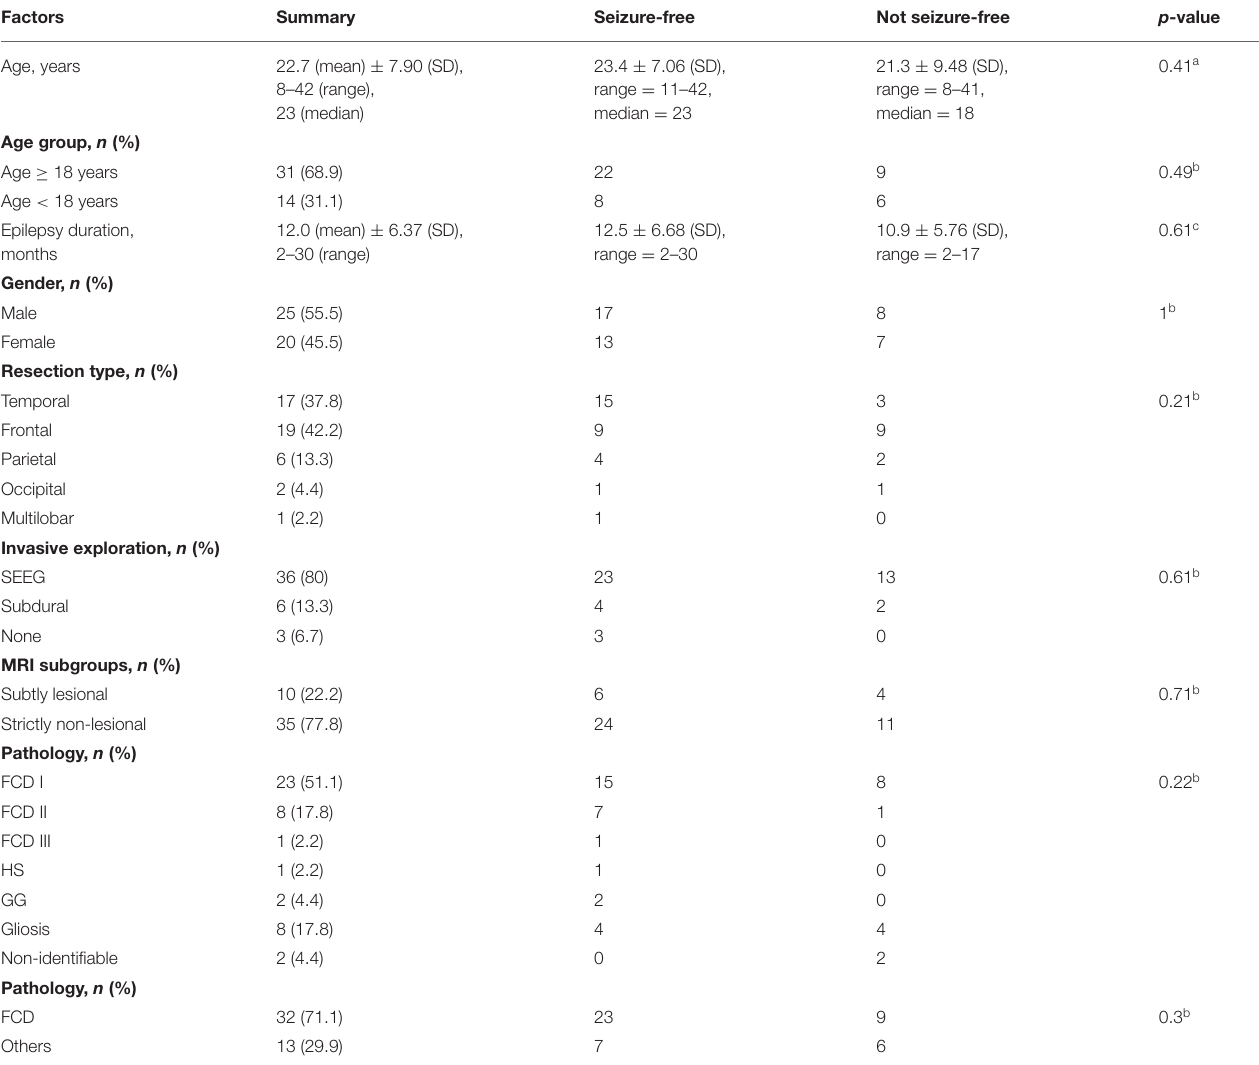
TABLE 1 | Detailed demographics and clinical data of the 45 patients studied. Factors Summary Seizure-free Not seizure-free p